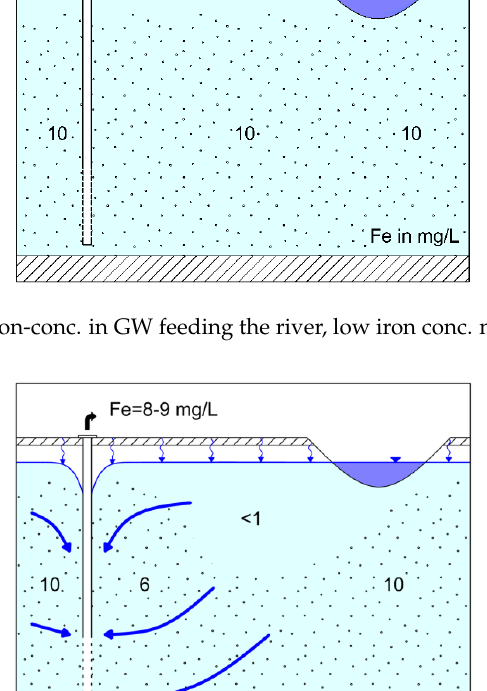
Figure 5. Case B – Significant decrease in iron conc. in in pumped water after years or decades. Figure 6. Change in iron conc. in pumped water (PW) with time depending on iron conc. in GW.